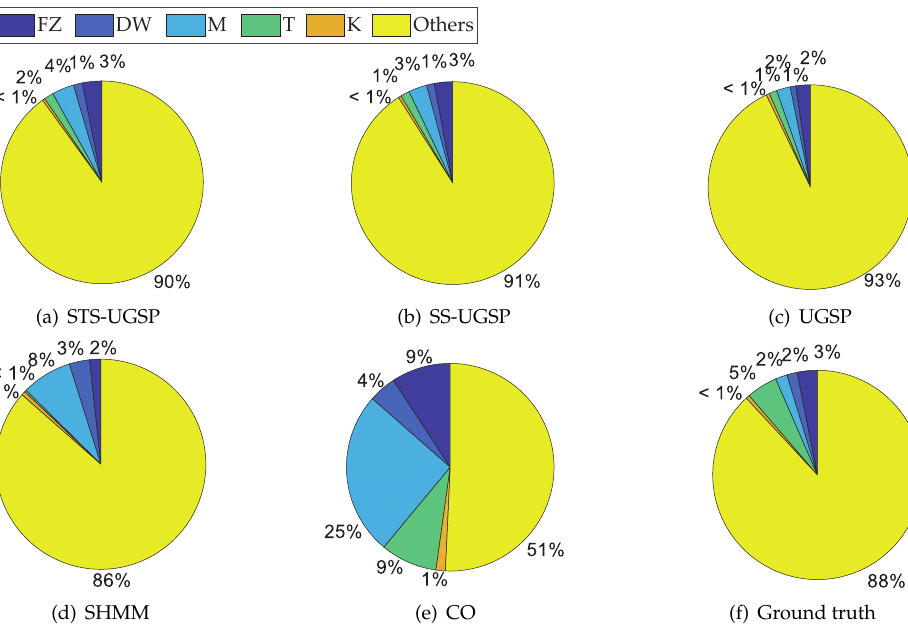
Figure 9. Pie charts of disaggregated energy shares for REFIT House